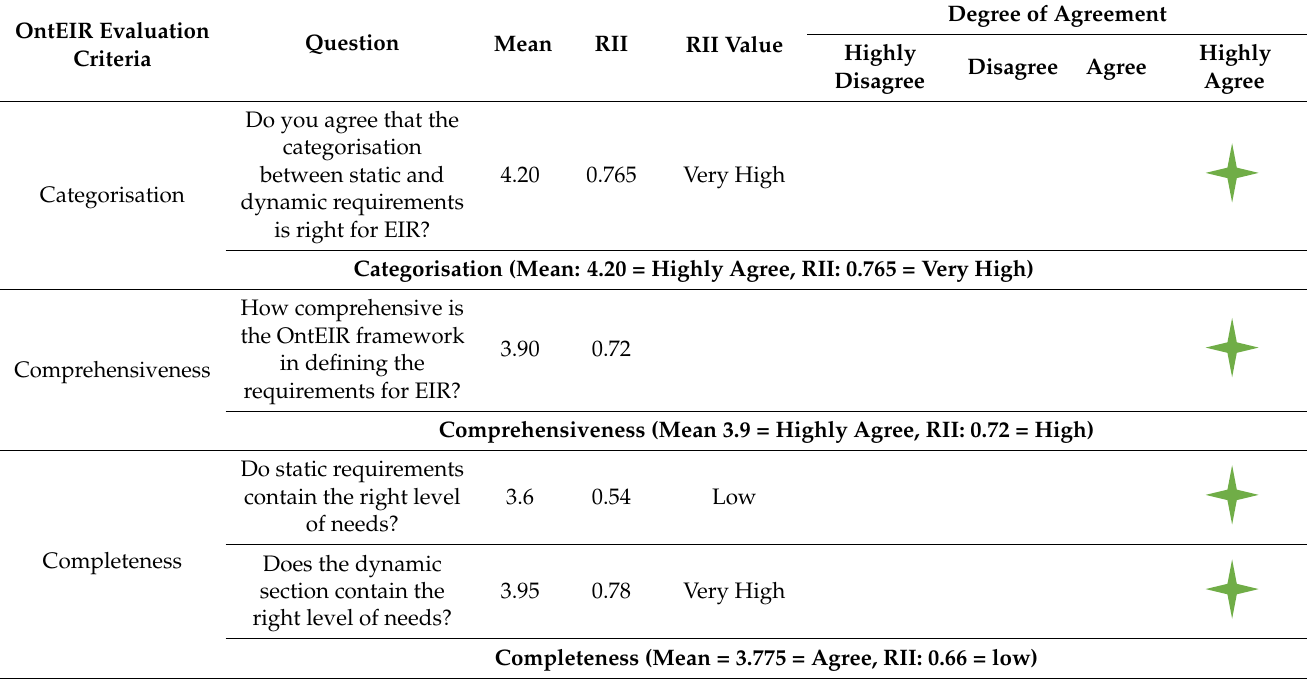
Figure 11. Responses to Question 3-b. Table 7. Descriptive analysis of OntEIR success criteria.